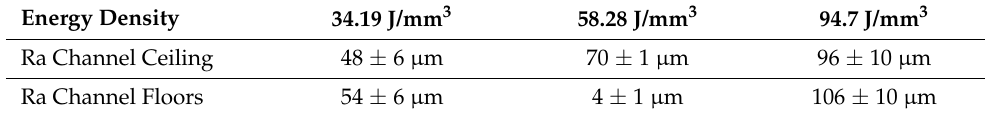
Table 2. Channel roughness of samples with low, medium, and high energy density.